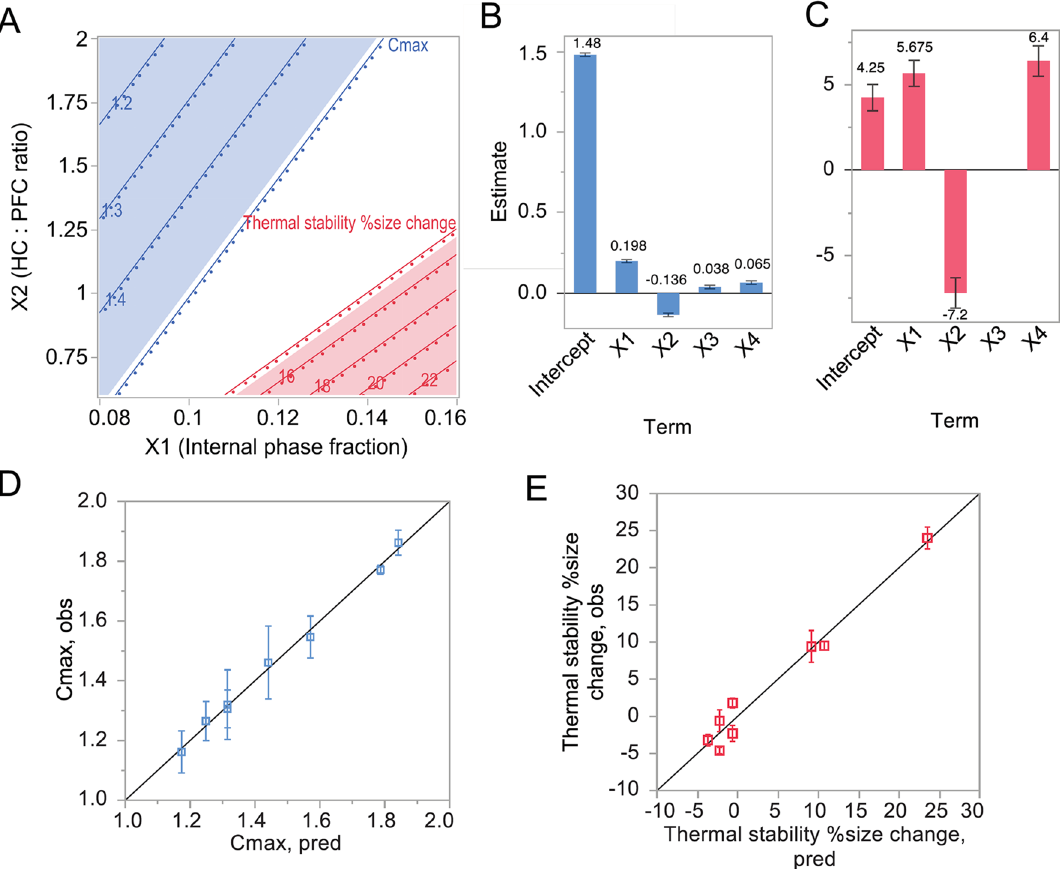
Figure 6. Multiple linear regression output to predict size change after thermal storage and C max in oxygen release. ( A ) Contour plot representing the formulation space in X1 and X2 identified by regression models for both responses. Shaded regions are out-of-specification regions for C max (blue) and Thermal stability Δsize (red). ( B - C ) Regression term estimates for C max (blue) and Thermal stability Δsize (red). ( D - E ) Observed by predicted graphs visualize the goodness of fit for both models, where C max is blue squares and Thermal stability Δsize is red squares. Graphs and analysis done in JMP Pro.